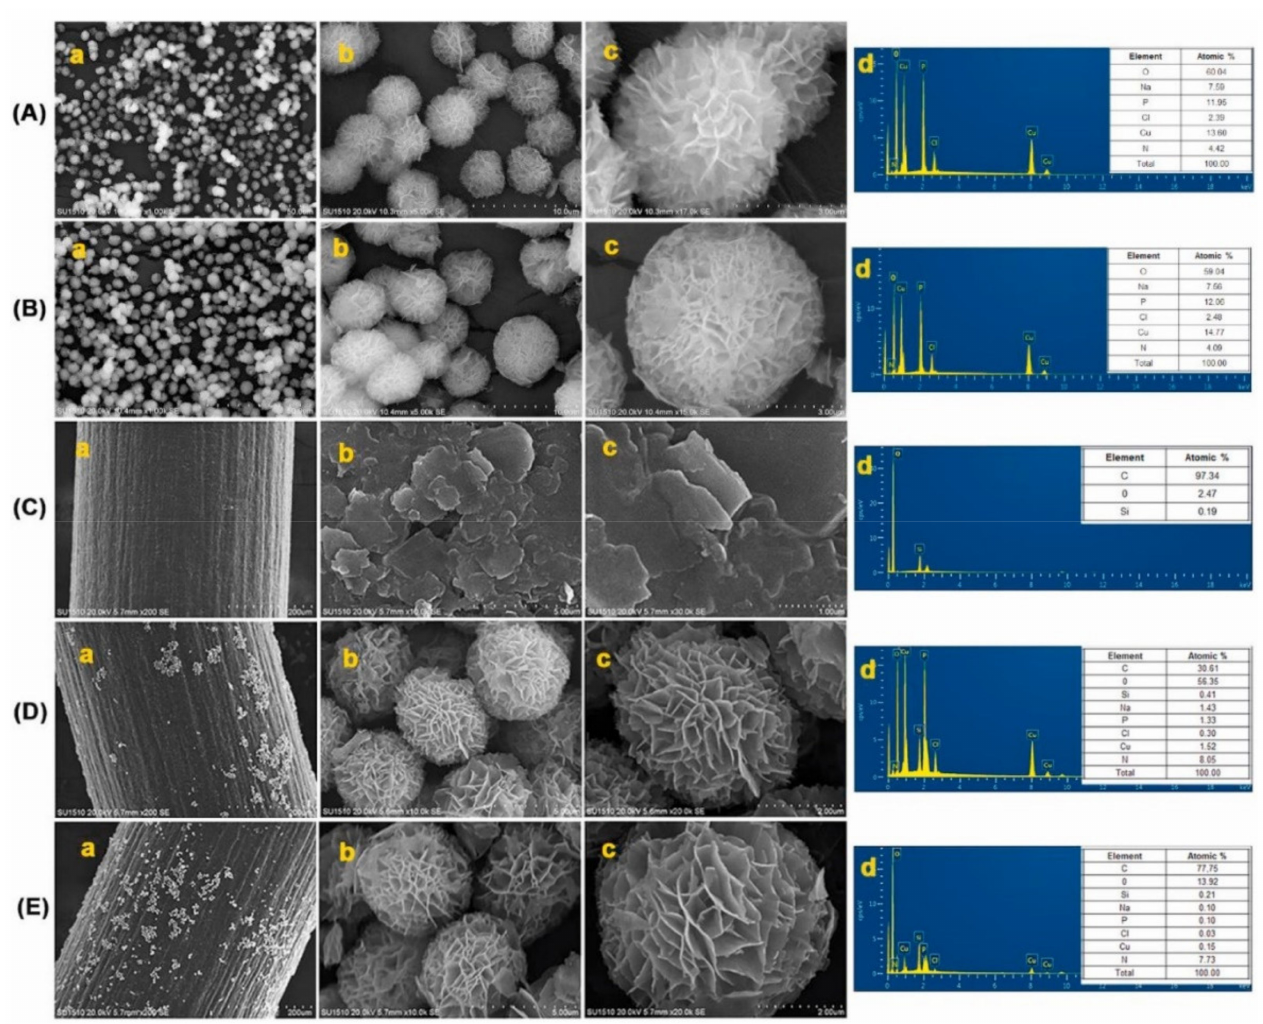
Figure 7. SEM image of ( A ) GNFs; ( B ) LNFs; ( C ) PGE; ( D ) GNFs-PGE; ( E ) LNFs-PGE (( a – c )—different resolutions) and EDX pattern ( d ). Figure adapted from the reference [52] with permission from